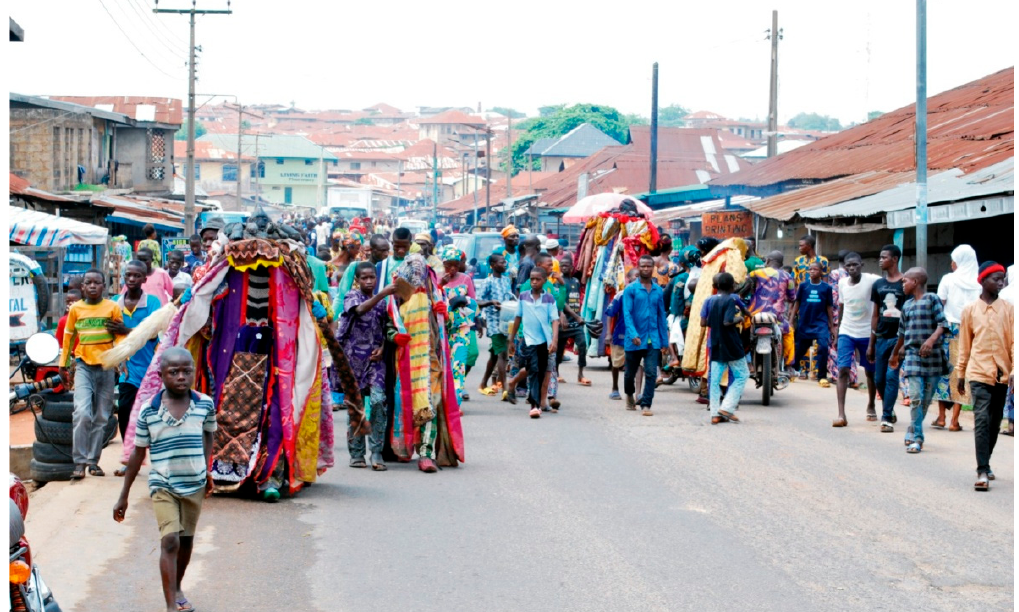
Figure 4. People and Egúngún going to the Òyó Palace Square for the 2018 Annual Egúngún Festival and Communion. Source: Photograph by author.